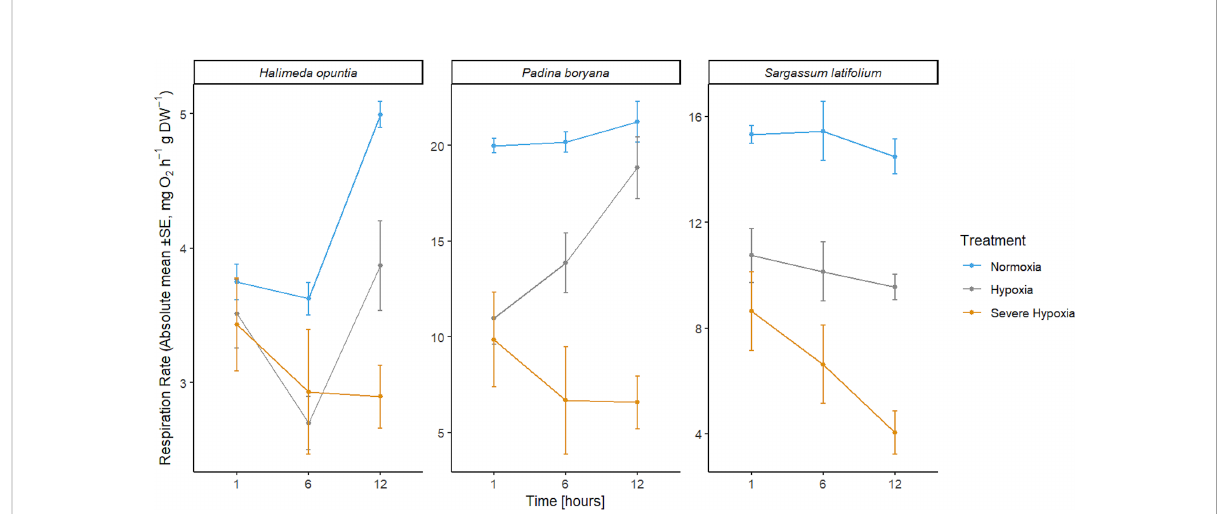
FIGURE 4 Mean absolute values of respiration rates ± SE (n=3) for the three different species Halimeda opuntia , Padina boryana , and Sargassum latifolium at the different time phases of the experimental duration.